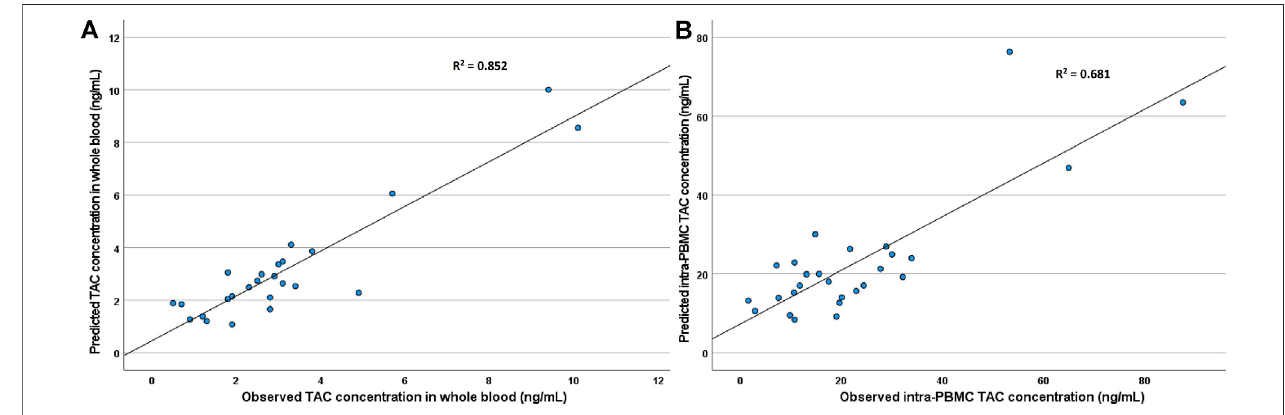
FIGURE 3 | Correlation between the observed TAC concentrations in WB (A) and PBMC (B) and the predicted concentration obtained by the regression model.